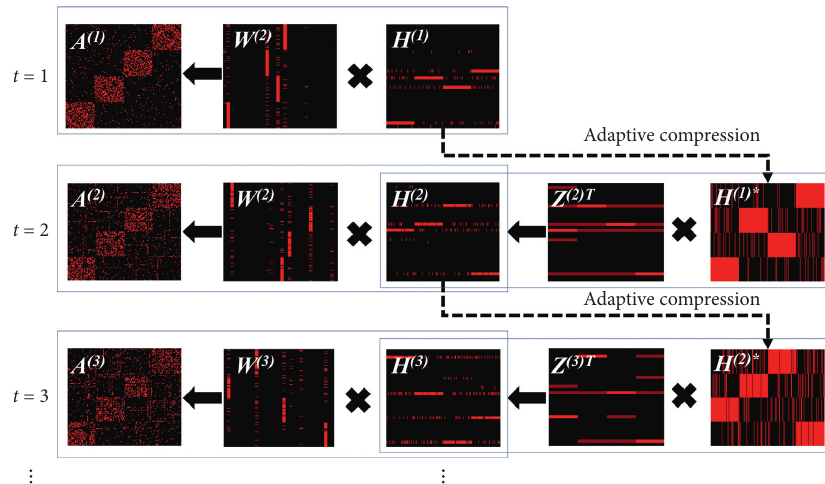
Figure 2: An illustration of EvoBNMF on network